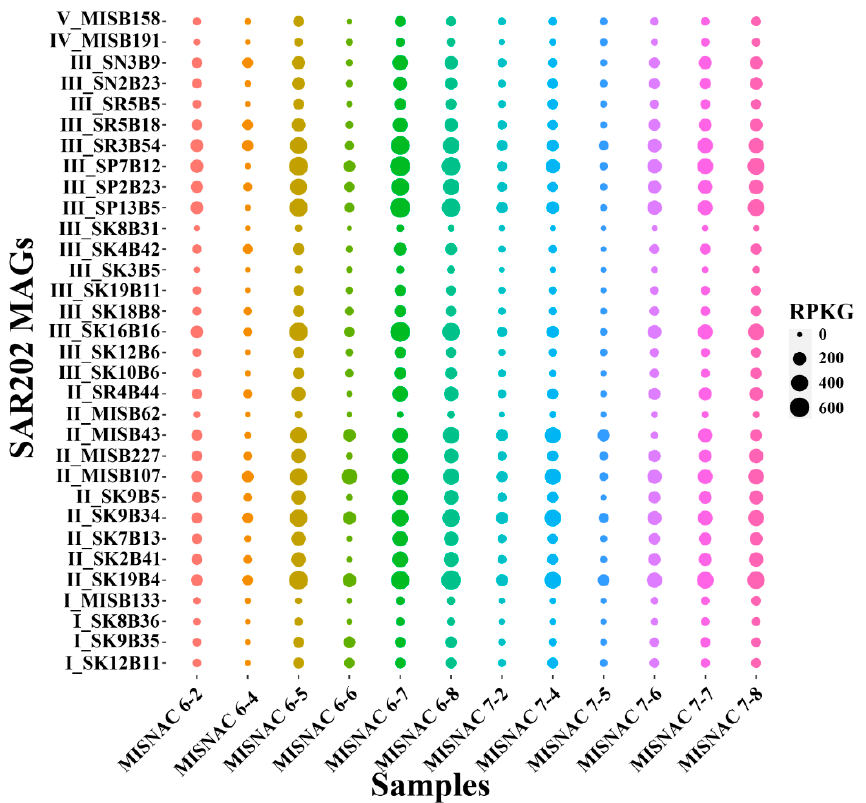
Figure 3. In situ transcriptional activities of SAR202 subclusters in the SCS. The dot size denotes the RPKG value, which reflects the in situ transcriptional activities of SAR202 species represented by different MAGs. The MAG IDs are initiated with a subcluster mark. The in situ samples were collected by MISNAC apparatus and the sampling time points are described in Table S1.